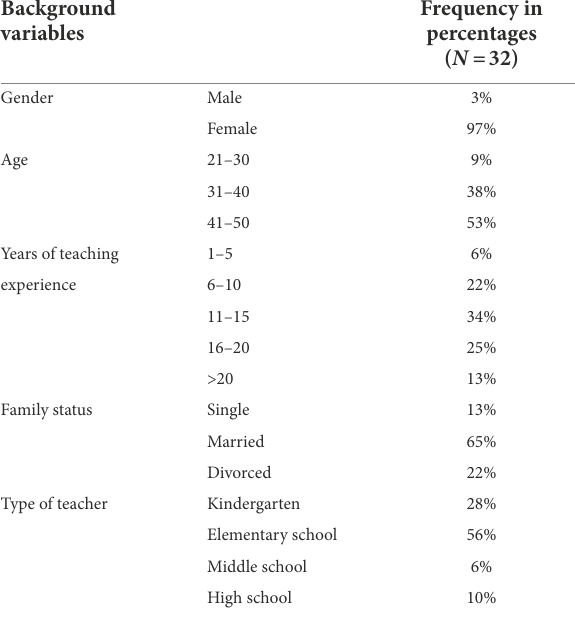
TABLE 1 Inservice teachers’ demographic